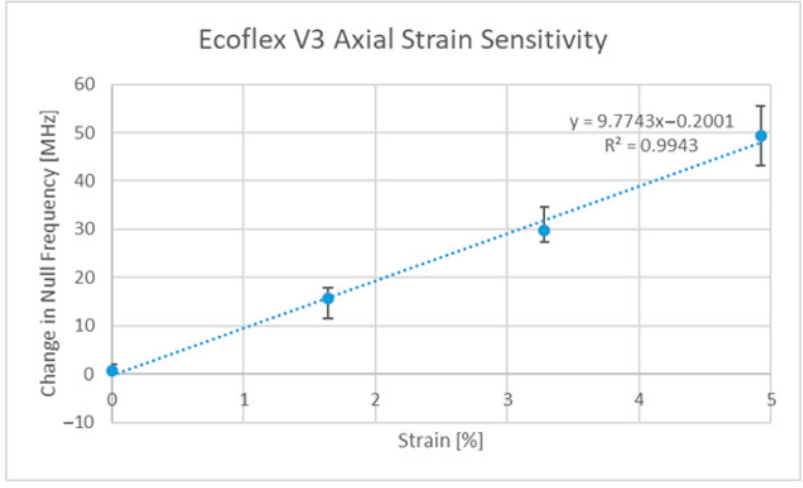
mation mechanism. The strain responses of this third version of the ELC ‐ inspired strain